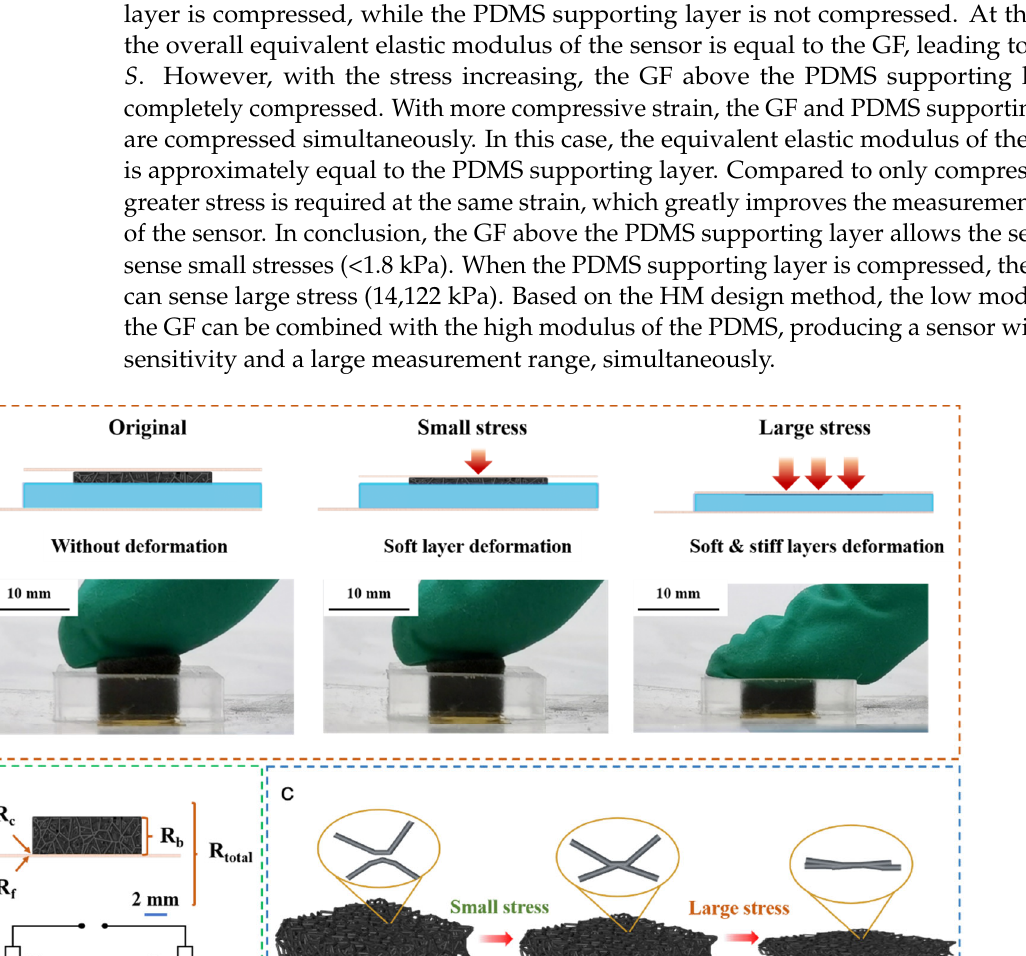
and the contact resistance between the GF and the interdigital electrode ( 𝑅 (cid:3030) ). The total resistance can be calculated as follows: 𝑅 (cid:3047)(cid:3042)(cid:3047)(cid:3028)(cid:3039) (cid:3404) 𝑅 (cid:3029) (cid:3397) 𝑅 (cid:3033) (cid:3397) 𝑅 (cid:3030) . Generally, the 𝑅 (cid:3033) and 𝑅 (cid:3030) can be neglected, and the piezoresistivity of the sensor is mainly determined by 𝑅 (cid:3029) . In this study, fi ve groups of GF samples were prepared by changing the dip-coating times. The conductivity of GF increases with the increase in dip-coating times, as shown in Figure S1. The conductivity of the GF increased rapidly for the fi rst three dip-coating times, while it increased slowly for the fourth and fi fth dip-coating times. According to the threshold e ff ect, higher sensitivity can be obtained by keeping the conductivity of piezoresistive composites near the threshold value. Therefore, in order to obtain be tt er pressure-sensi- tive characteristics, GF 3 foam samples with the largest change in conductivity should be selected. The conductivity of GF 3 is about 0.086 S m − 1 . In the follow-up studies of this ex- periment, GF 3 samples were used. 𝑅 (cid:3029) depends on the number of conductive paths of the GF and can be equivalent to a sliding rheostat. Without stress, HMFPS remains in its orig- inal state, with a resistance of 𝑅 (cid:2868) . Applying stress compresses the GF, resulting in a de- formation ( ∆ℎ ). The 𝑅 (cid:3029) of the GF decreases according to 𝑅 (cid:3029) ∝ 1/ ∆ℎ . The sensitivity and measurement range of the sensor are determined by the relationship between the ∆ℎ and the 𝑃 , which can be expressed as 𝐸 (cid:3404) 𝑃 / ∆ℎ (where 𝐸 represents elastic modulus of the sensor). Within a certain stress range, the applied stress only works on the GF, and the 𝐸 of the sensor is small. The smaller 𝑃 can produce a larger ∆ℎ , indicating a large variation rate of the 𝑅 (cid:3029) , so that the sensor has high sensitivity. Beyond a certain range, the existence of the PDMS supporting layer increases the 𝐸 of the sensor, which generates a certain amount of the ∆ℎ that requires a larger 𝑃 . The variation rate of the 𝑅 (cid:3029) decreases, increas- ing the measurement range of the sensor. The sensing mechanism of the HMFPS is shown in Figure 3c. The entire sensing range can be divided into two stages, which are the low stress range and the high stress range. In the original state, graphene is uniformly covered on the MF surface, forming a stable conductive network. Applying stress contacts the adjacent skeleton of the GF, establishing